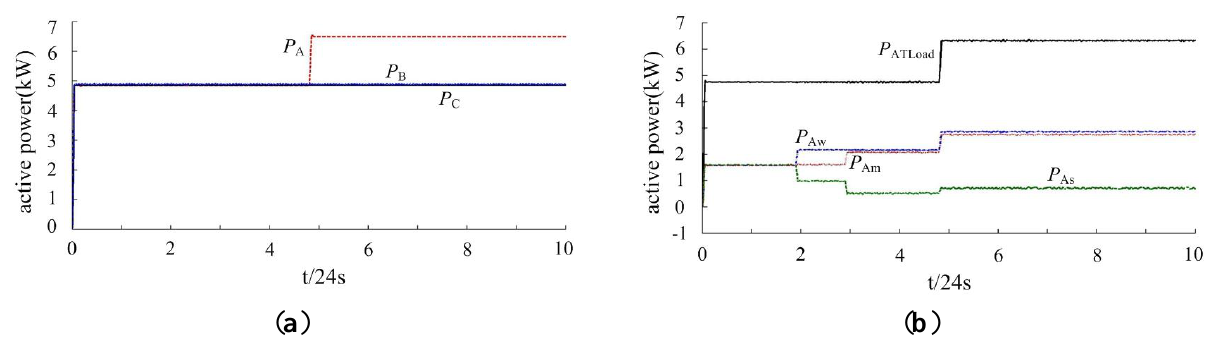
Figure 12. Output voltage and current of three phase system within 10 cycles. ( a ) Phase current; ( b ) Line